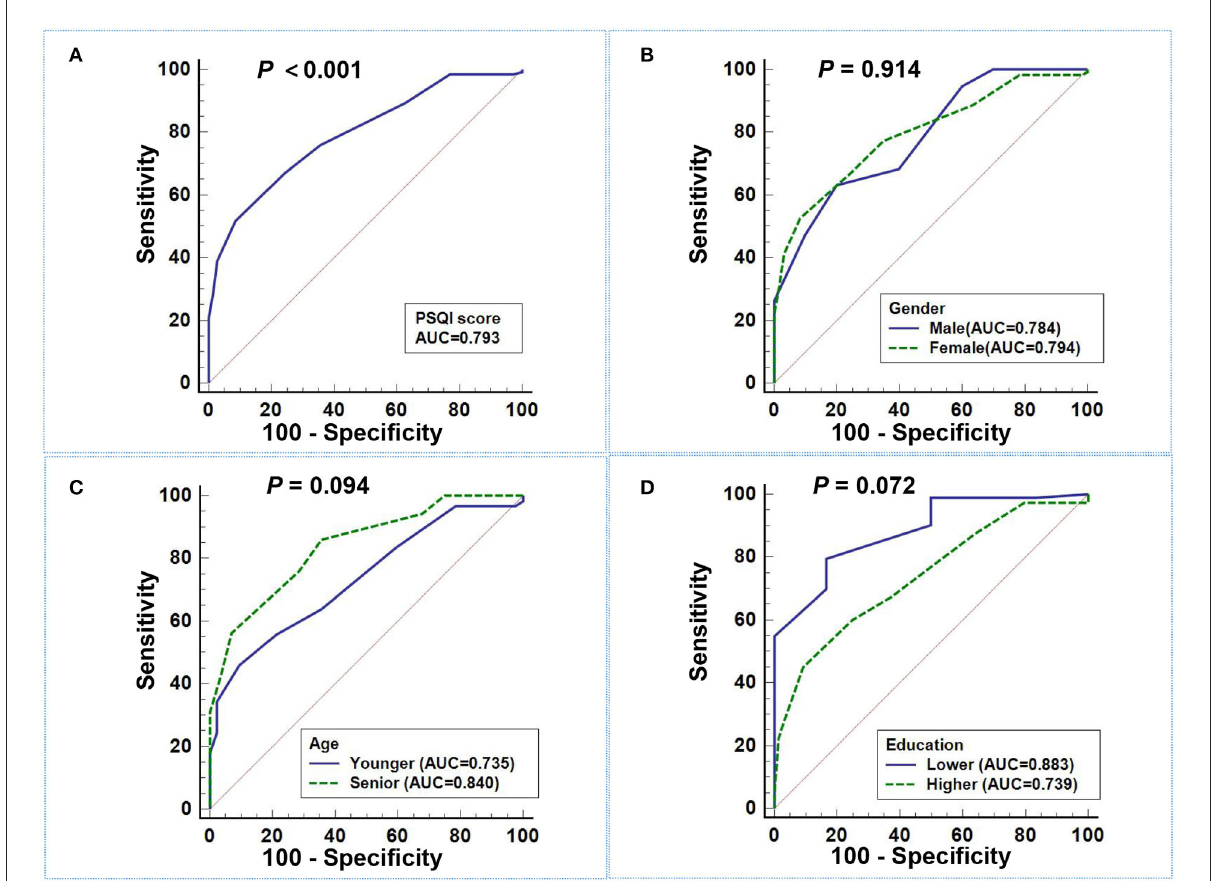
FIGURE1 ROC curve of PSQI score in predicting migraine. (A) The AUC of PSQI score in predicting migraine in total subjects was 0.793 (95%CI: 0.731–0.847). (B–D) There were no significant differences in the AUC of PSQI score to predict migraine among different gender (B) , age (C) , and education (D) subgroups (all P >